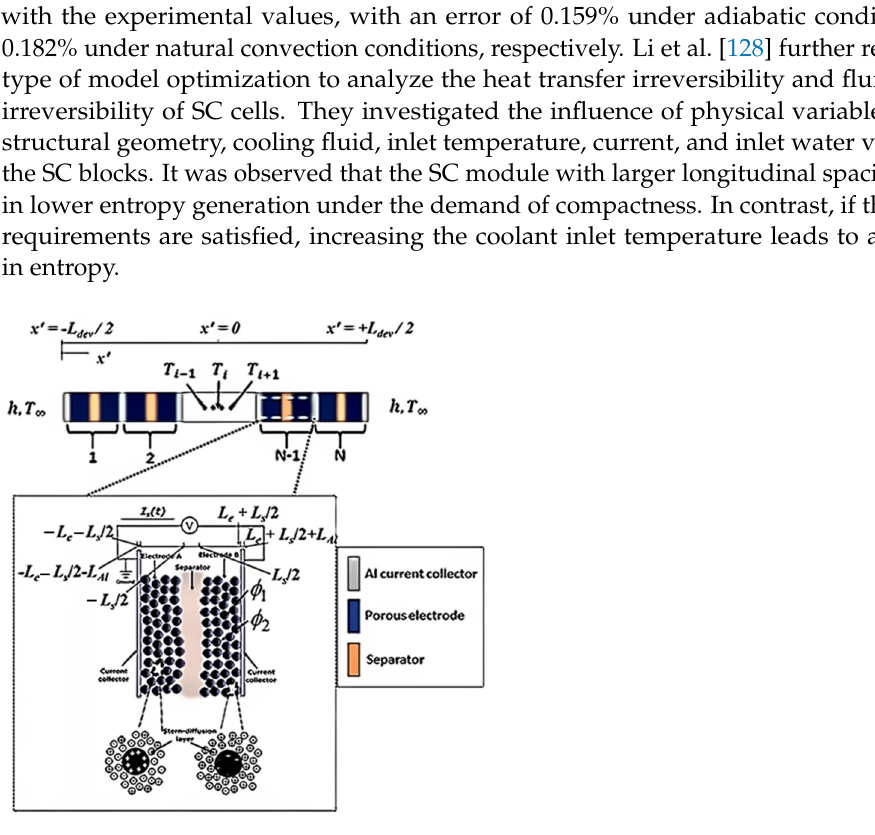
Figure 12. Electrochemical model of an SC, reproduced with permission from [104]. Copyright 2021, Elsevier.